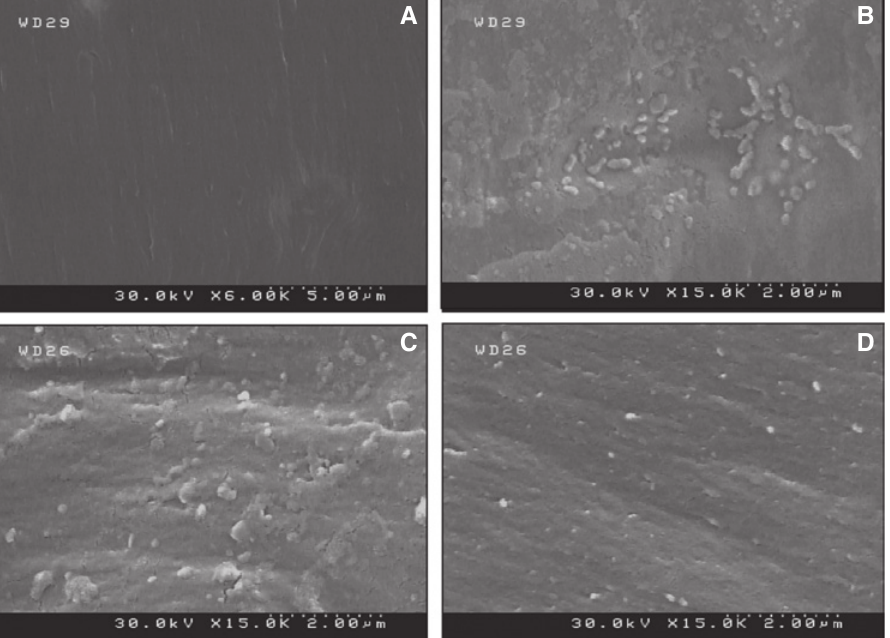
Figure 10: FE-SEM images of epoxy-acrylate nanocomposites. (A) Blank, (B) 3% w/w CuO, (C) 3% w/w CuO + TEMS, and (D) 3% w/w CuO +